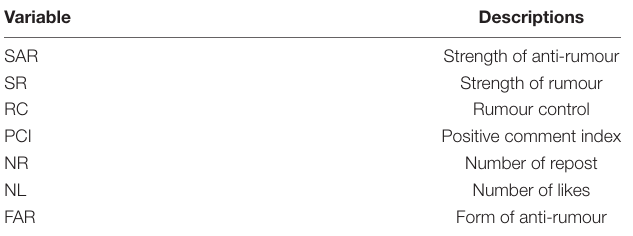
TABLE 3 | List of symbols.